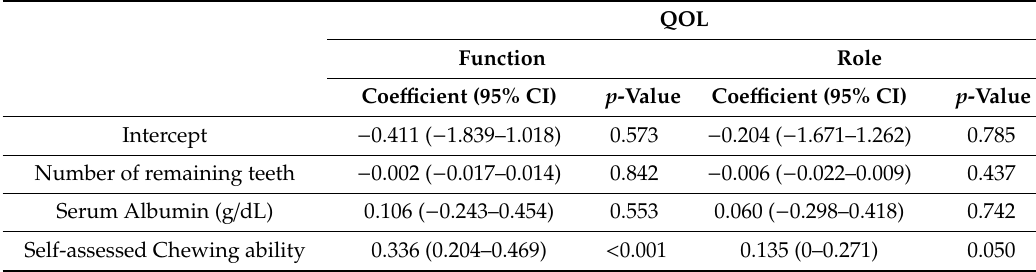
Table 1. Correlations of the number of remaining teeth, serum albumin level, and self-assessed chewing ability with quality of life (QOL).